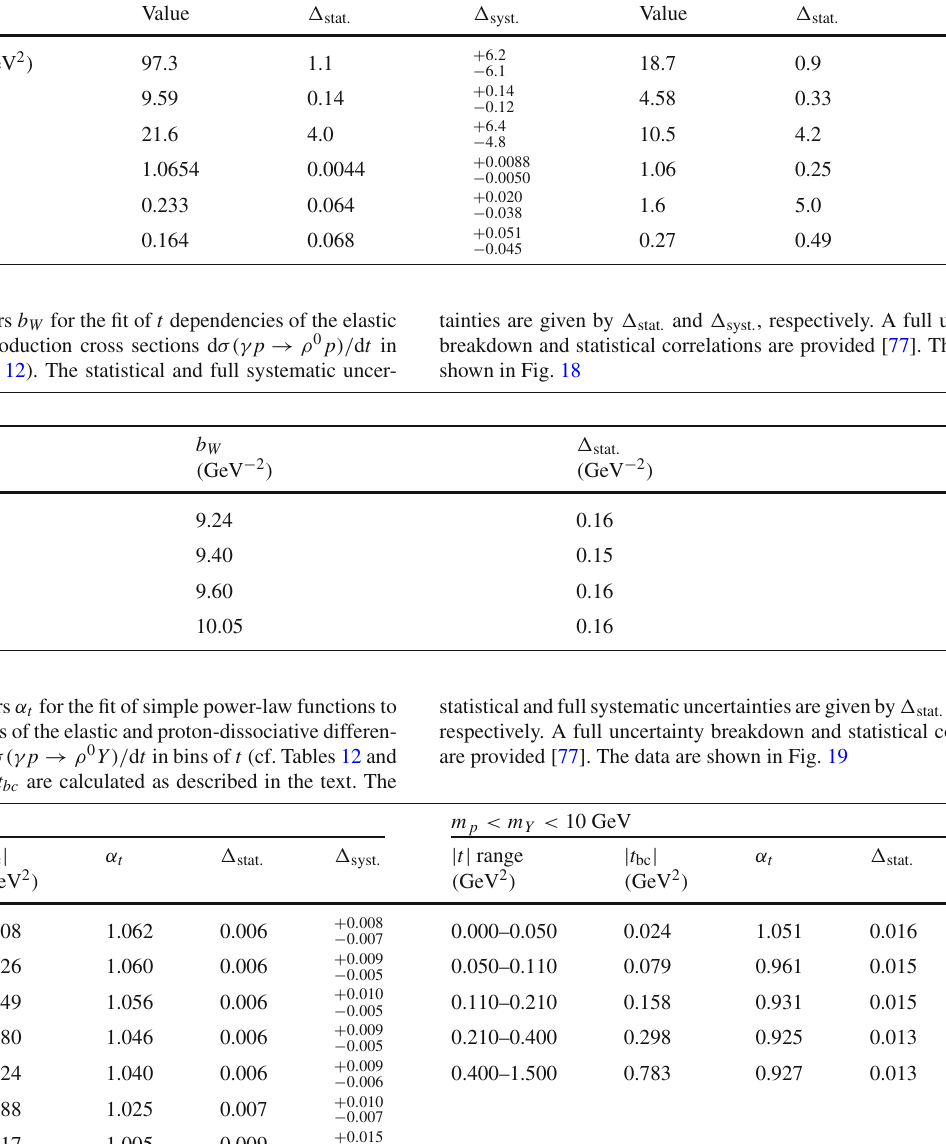
Table 14 Fit parameters of the Regge fit of the t and W γ p depen- dencies of the ρ 0 meson photoproduction cross sections in the range 20 < W γ p < 80 GeV and | t | < 1 . 5 GeV 2 . The nominal fit values